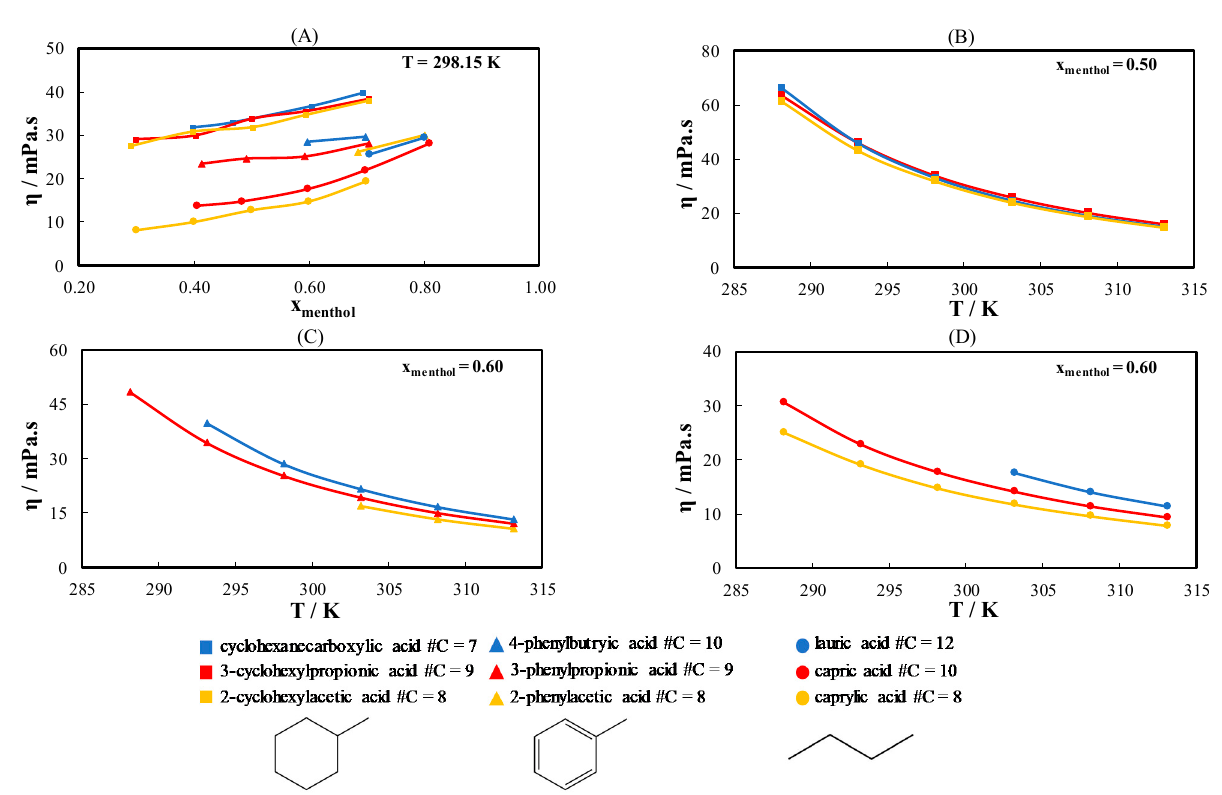
Figure 4. ( A ) Viscosity of ideal eutectic systems containing L -menthol and different monocarboxylic acids as a function of the L -menthol composition at T = 298.15 K. ( B ) Viscosity of the eutectic systems containing L -menthol and different cyclohexyl acids at x menthol = 0.50. ( C ) Viscosity of the eutectic systems containing L -menthol and different phenyl acids at x menthol = 0.60. ( D ) Viscosity of the eutectic systems containing L -menthol and different linear acids at x menthol = 0.60.